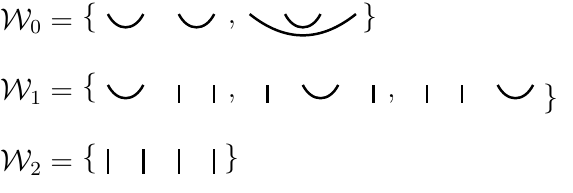
Figure 16 . The representation spaces of the Temperley-Lieb algebra acting on N = 4